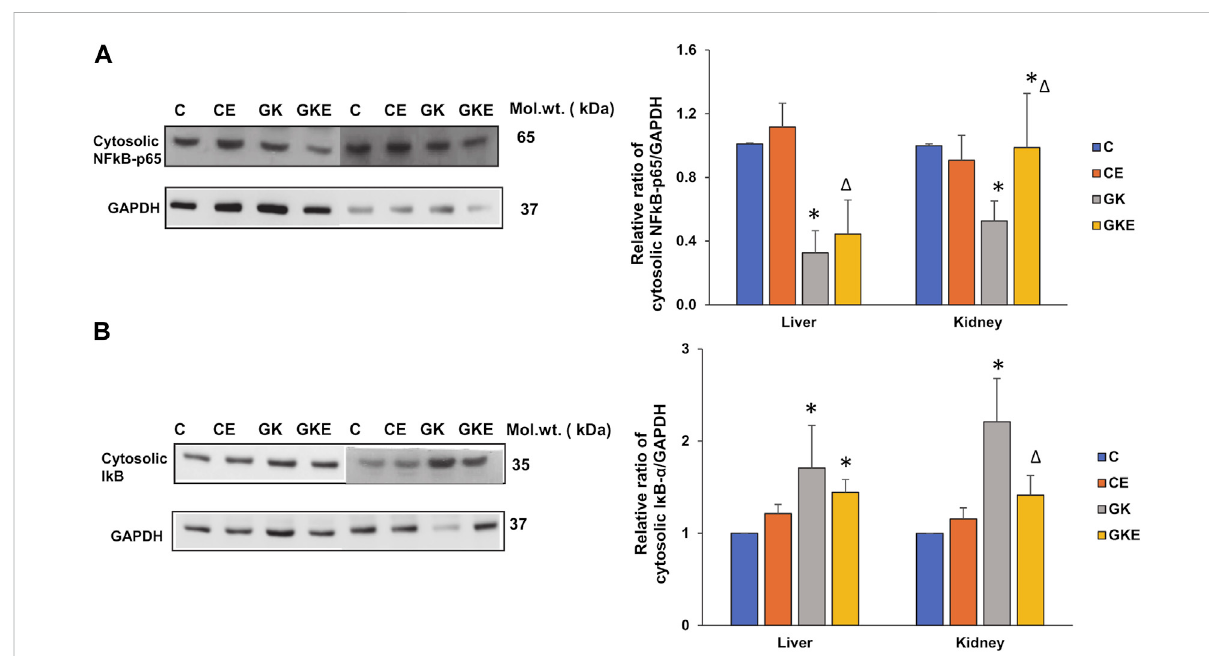
FIGURE 7 Exercise-inducedalterations intheexpressionofin fl ammatorymarkerproteinsintheliverandkidneyofcontrolWistar(C)anddiabeticGK(GK) and exercise-trained control (CE) and GK (GKE) rats ( n = 5). Cytosolic fractions were electrophoretically separated by 10% SDS-PAGE, transferred onto nitrocellulose membranes and immunoblotted with in fl ammatory marker proteins, NF κ B-p65 (A) , and I κ B (B) and visualized using the Sapphire Biomolecular Imager (Azure Biosystems, Dublin, OH, United States) or by exposure to X-ray fi lms. GAPDH was used as the loading control. Immunoreactive bandswere quantitated using ImageStudioLite, ver.5.2 (LI-COR Biosciences,Lincoln, NE, UnitedStates).Histogramsrepresent the relative ratio of protein to the loading control from three independent experiments. Statistical signi fi cance is shown as asterisks, which was fi xed as p < 0.05 (* indicates statistical signi fi cance compared with control Wistar rat tissues while Δ indicates statistical signi fi cance compared with diabetic GKrattissues).MolecularweightsoftherespectiveproteinsareindicatedinkDa.Originalwesternblot fi